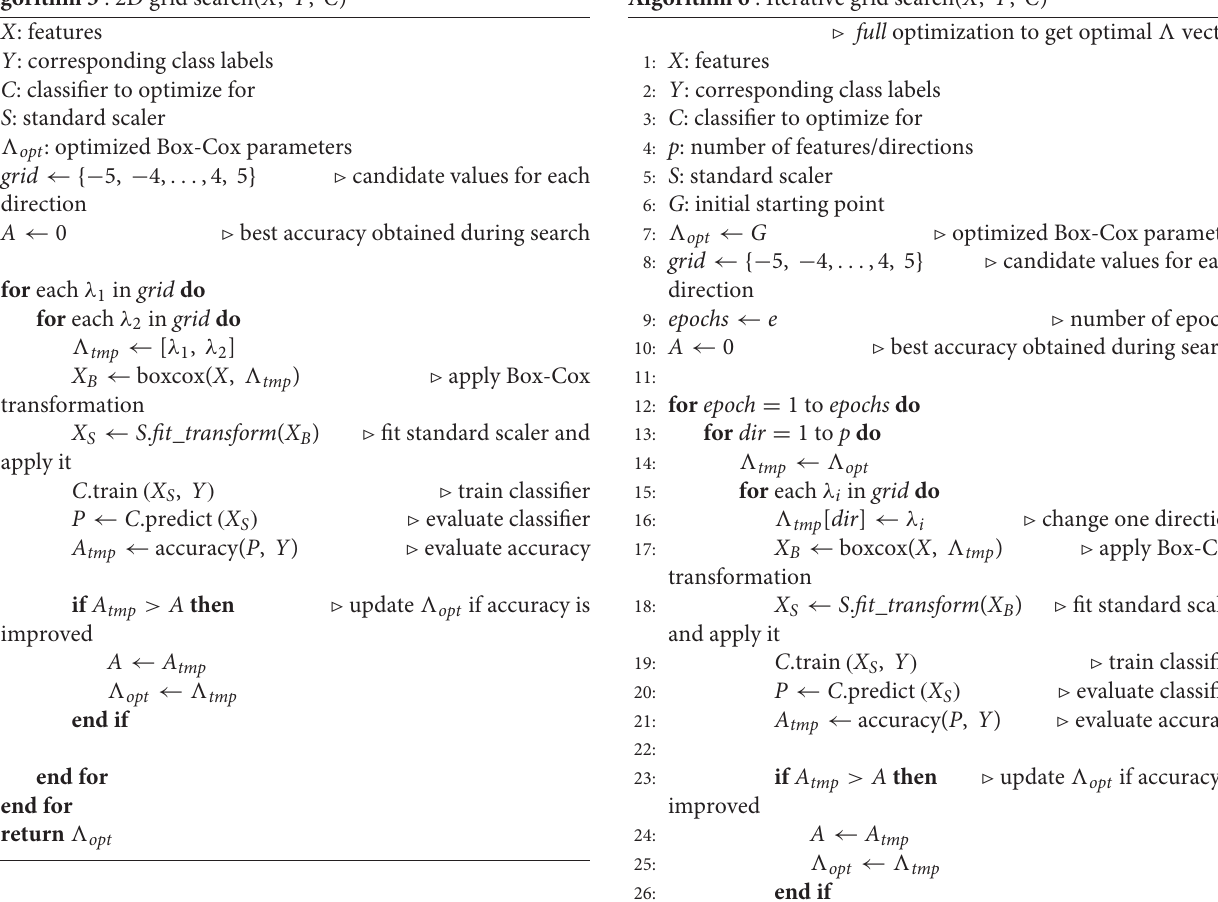
procedure for training in Algorithm 3 in line 9. Assuming model